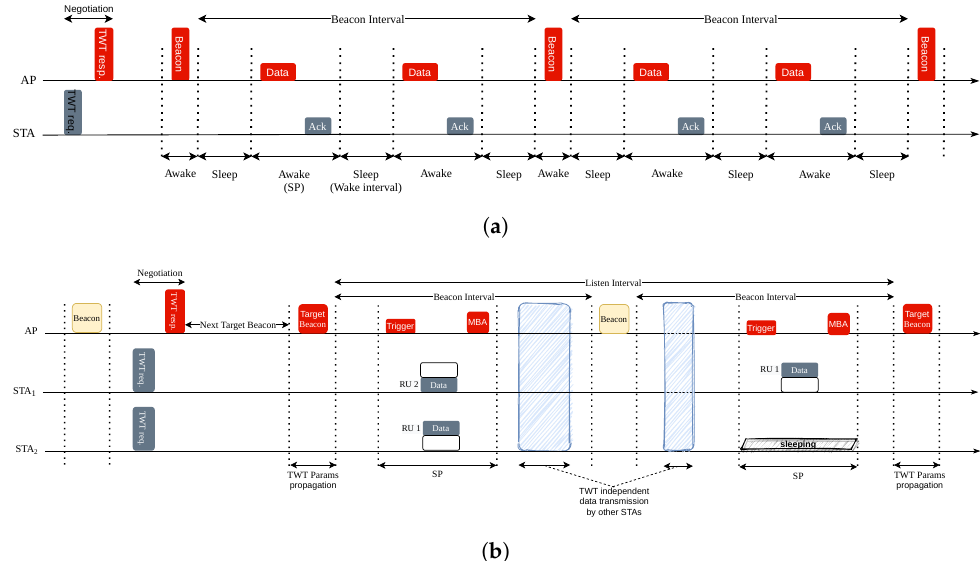
Figure 14. Individual and broadcast TWT agreements. ( a ) Implicit, non-trigger-enabled, and unan- nounced individual agreement. Three Service Periods (SPs) are scheduled periodically within one beacon interval. ( b ) Trigger-enabled, unannounced broadcast agreement. Two SPs are scheduled on two different listen